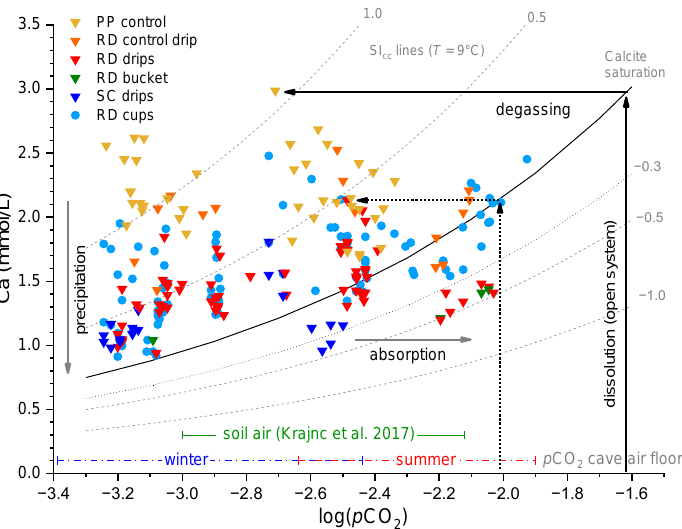
Figure 11. Water chemistry evolution for the drip and cup water samples collected at Pisani Passage. The grey curves denote constant SI cc values at T = 9 °C. The arrows show the direction of the dominant processes in the carbonate water chemistry. Explanations can be found in the text. The green line marks the log( p CO 2 ) range measured in the soil, while the blue and red dashed lines mark the winter and red ranges, respectively.